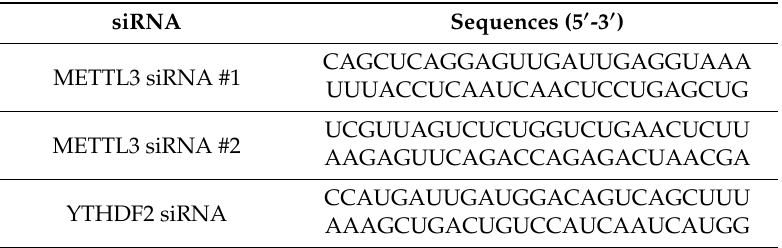
Table 1. siRNA sequences for